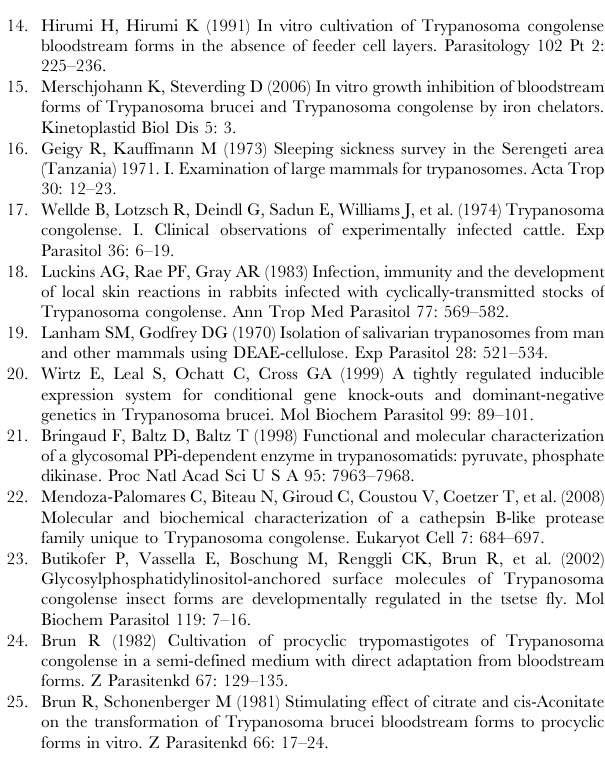
Figure S1 Acute and chronic infection in mice. 5 Balb-c mice were infected with 104 parasites of IL3000 or IL1180 T. congolense strains. Parasitaemia and PCV were measured and expressed as mean values. Table S1 Metacyclogenesis timing of various T. congolense strains. Cytoadherence timing indicates the time required to observe an